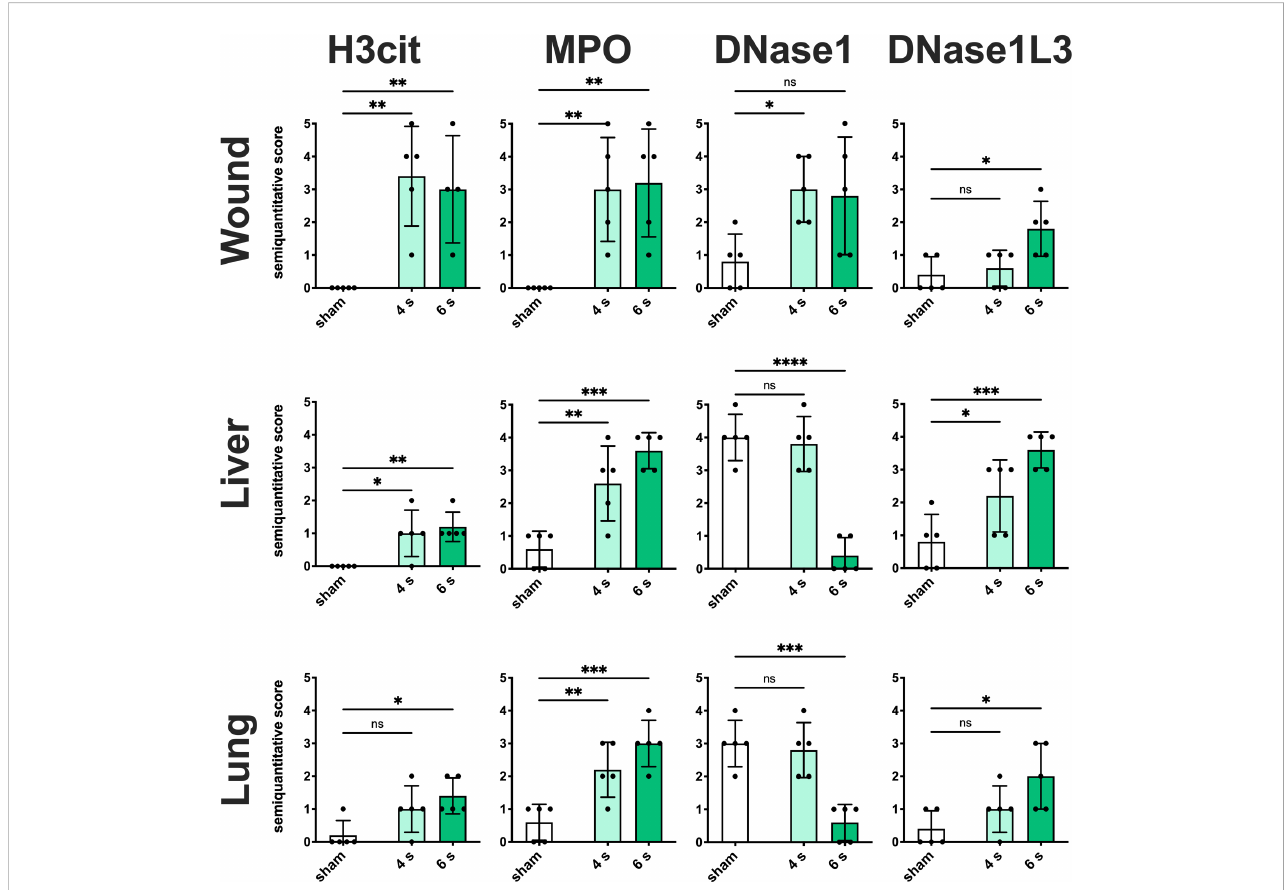
FIGURE 4 6 s scald leads to a signi fi cant NET release, an upregulation of DNase1L3, and downregulation of DNase1. Semiquantitative scores were used to estimate the amount of H3cit, MPO, DNase1, and DNase1L3. Results are provided as mean ± SD and one-way AVONA with Dunnett ’ s correction was performed. The levels of signi fi cance: ns, not signi fi cant; *p < 0.05; **p < 0.01; ***p < 0.001; ****p <